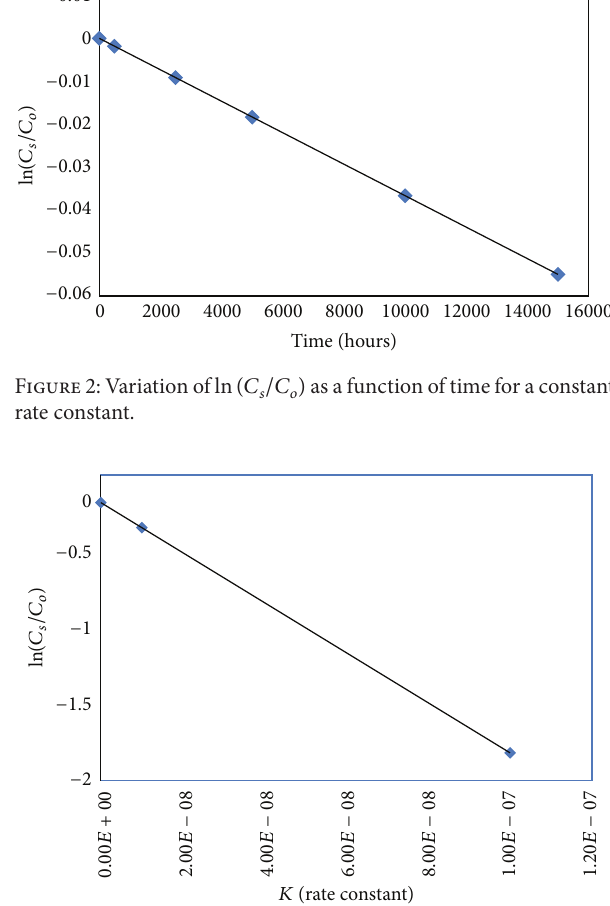
Figure 3: Variation of ln (𝐶 𝑠 /𝐶 𝑜 ) as a function of different rate